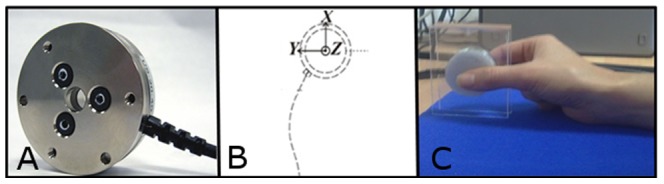
Experimental material.(A) Grip-force sensor (ATI mini-40). (B) A diagram specifying the 3 force axes measured by the load cell. (C) The hand position that was maintained by the participants throughout the experiment.